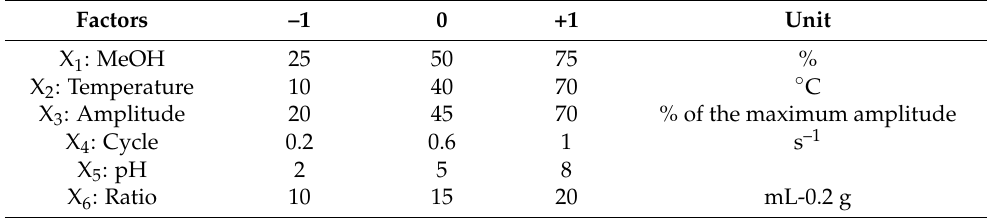
Table 1. Range of values used in the Box–Behnken design (BBD).